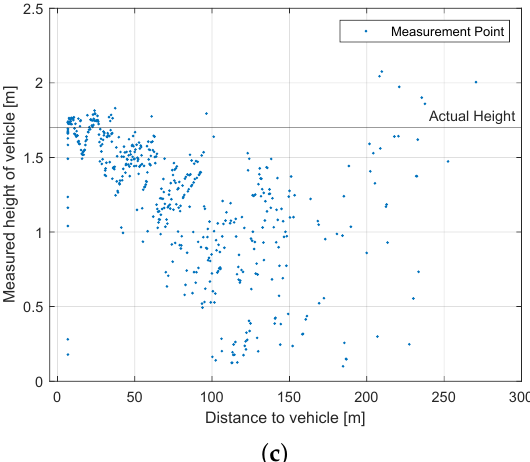
Figure 11. Results for Scenario 4. Measured height in relation to the distance to the second vehicle. ( a ) Velodyne Velarray (1175 vehicle detections); ( b ) Robosense M1 (522 vehicle detections); ( c ) Livox Horizon (468 vehicle